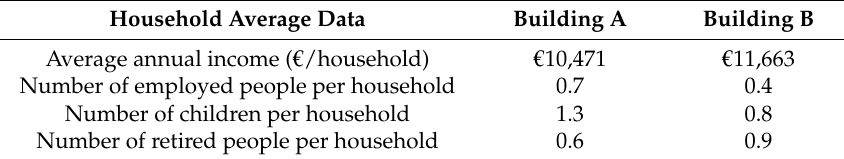
Table 4. Average socio-economic characteristics of households in Buildings A and